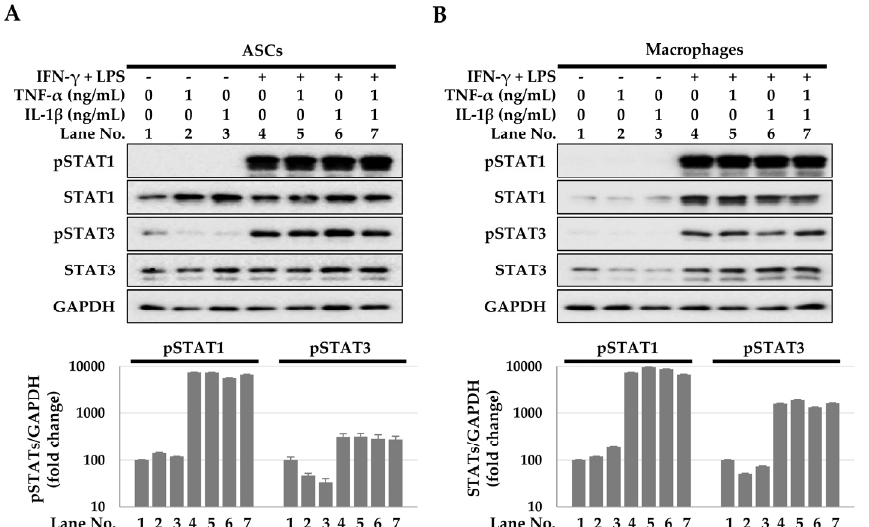
Figure 4. STAT1/3 phosphorylation in ASCs and macrophages. To detect STAT1/3 phosphorylation, protein samples were prepared after 15 min of treatment with TNF- α , IL-1 β , and/or IFN- γ + LPS and analyzed using immunoblotting in ASCs ( A ) and macrophages ( B ). The data shown represent one of three independent experiments.